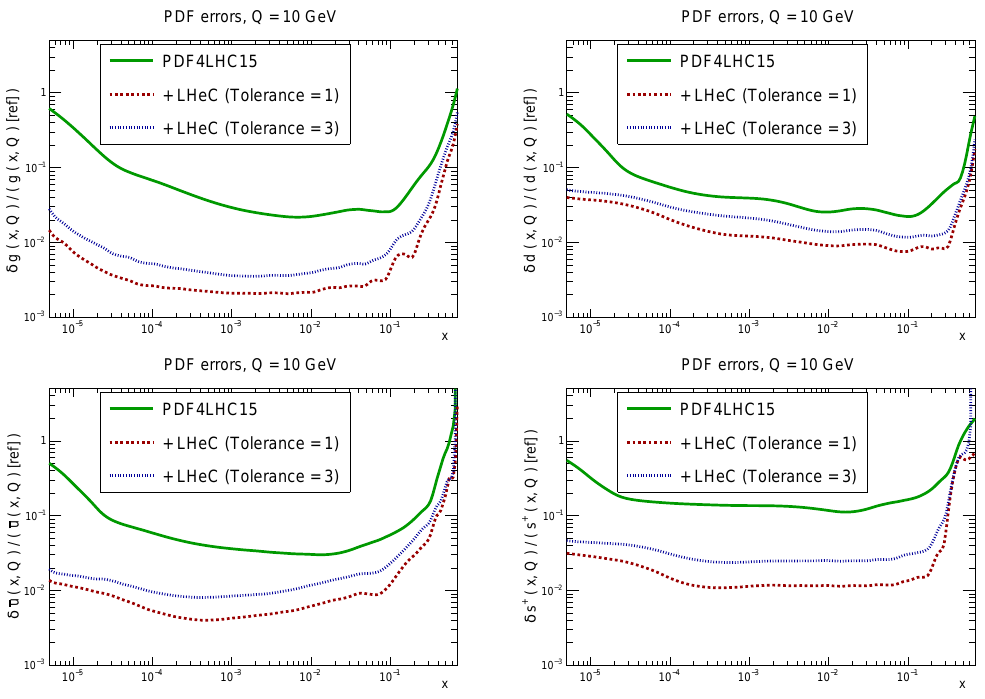
Figure 4.2: Same as Fig. 4.1 for the complete LHeC dataset, now comparing the baseline results obtained with a tolerance T = 3 with those based on T =